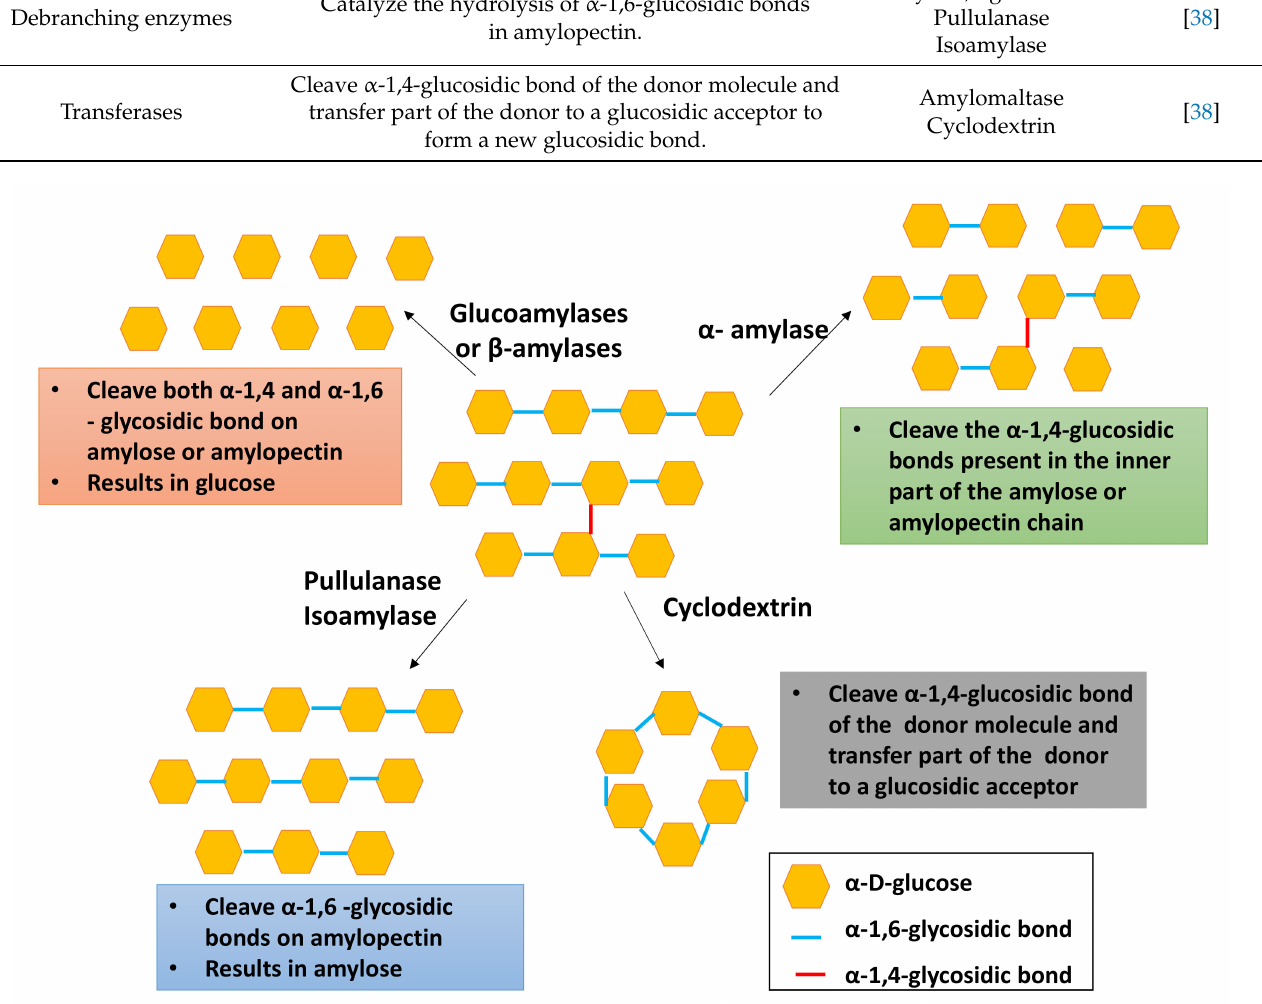
Figure 4. Enzymatic hydrolysis of